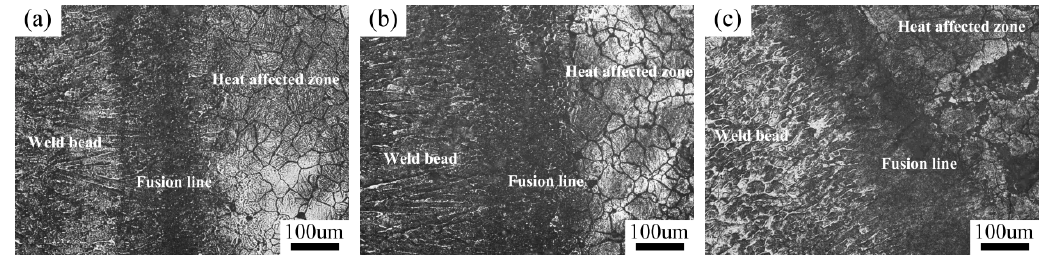
Figure 11. Microstructure of fusion zone at different heat inputs. ( a ) 4.2 kJ/cm, and ( b ) 5.4 kJ/cm, ( c )